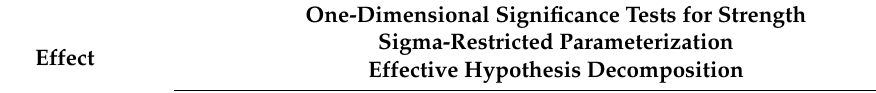
Table 6. Results of two-way ANOVA for the compressive strength of mortar beams doped with d2, d3, and d5.